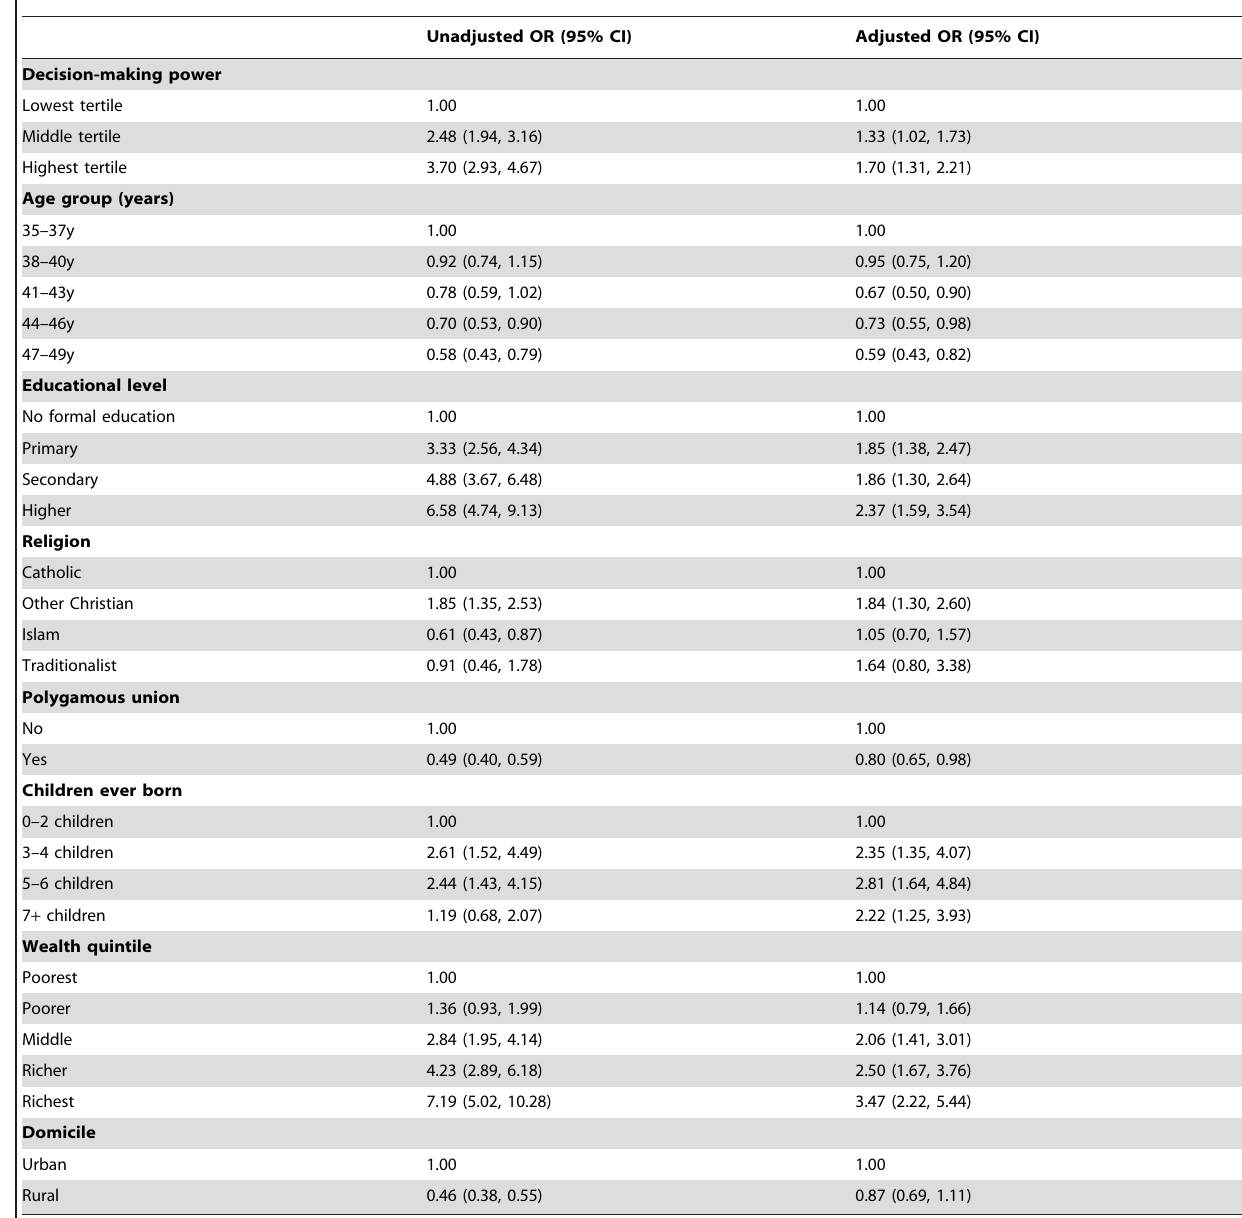
Table 3. Odds Ratios and 95%CI of Current Modern Contraceptive Use among Nigerian Women